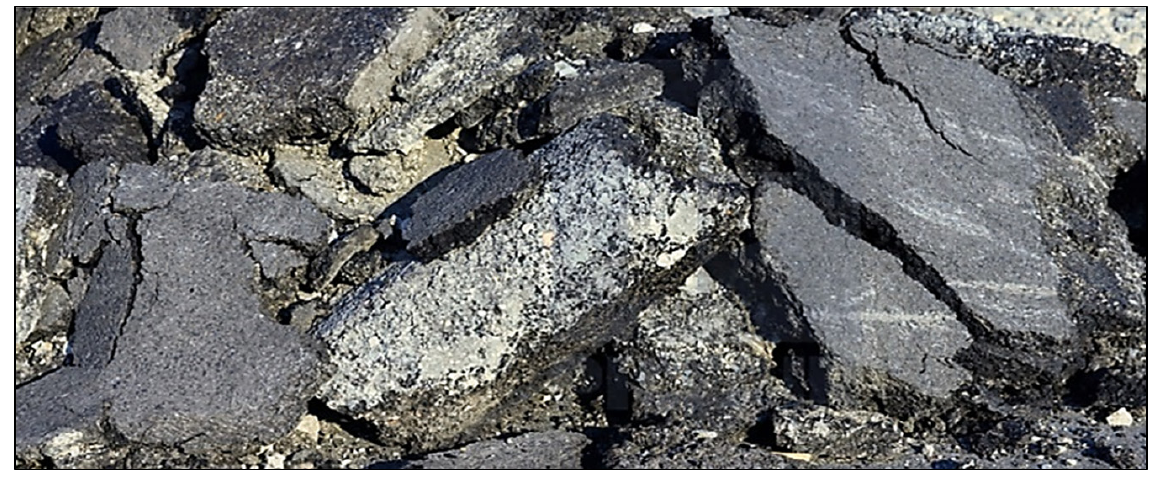
Figure 1. RAP stockpile. Table 1. Physical characteristics of